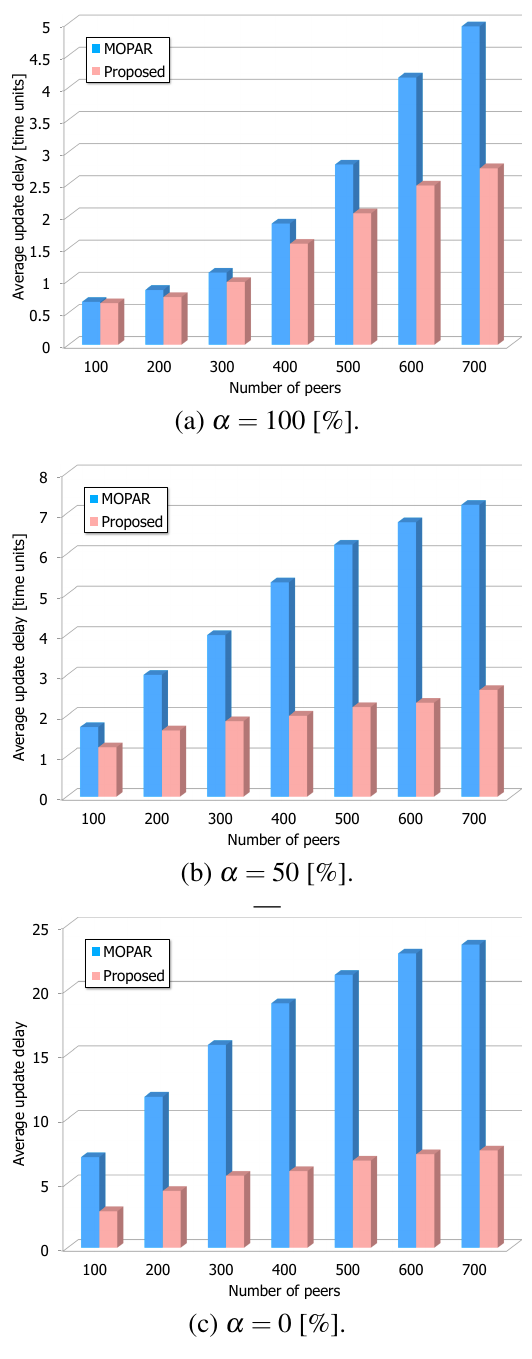
Fig. 8. Result of